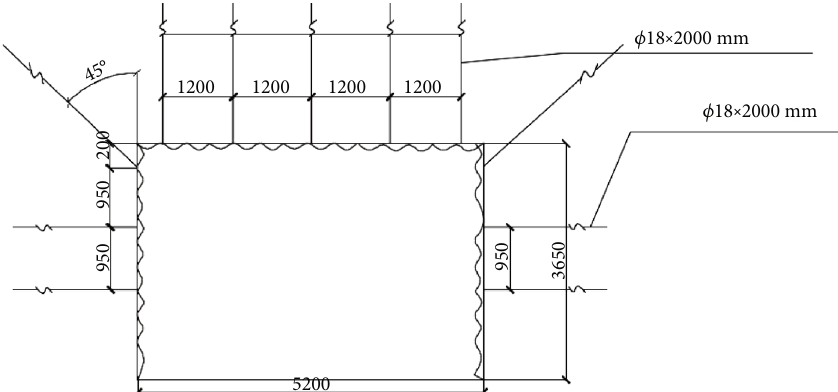
Figure 15: Original supporting plan.